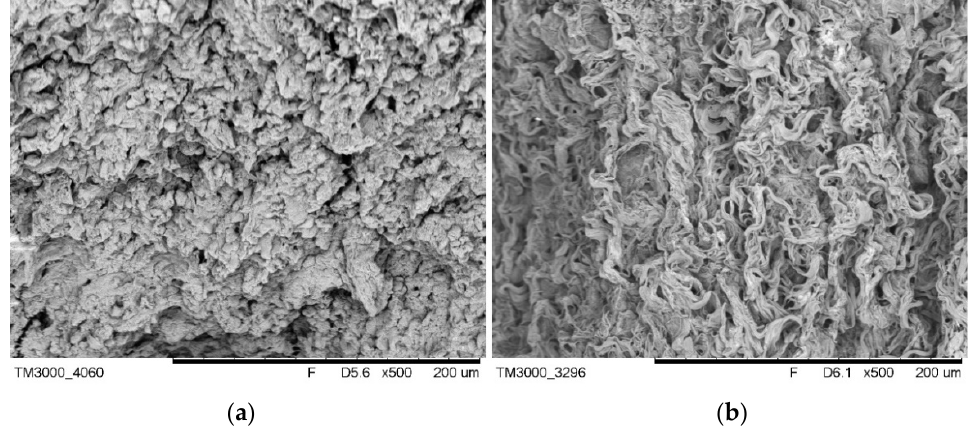
Figure 10. SEM image of native (( a ); magnification 500×) and decellularized (( b ); magnification 500×) pancreas.